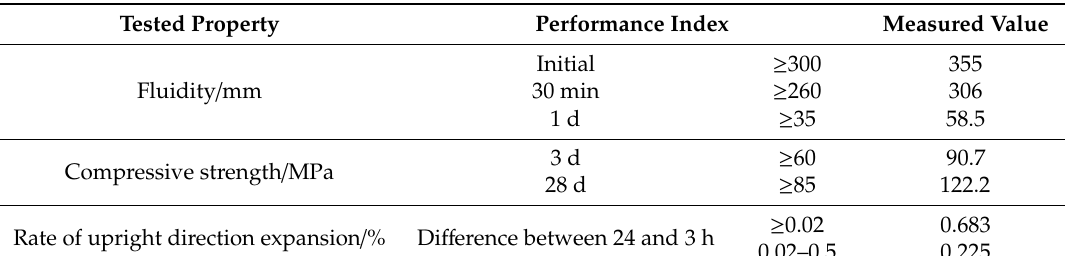
Figure 4. Schematic of the test specimen. Table 2. Specifications for the grouting material characteristic